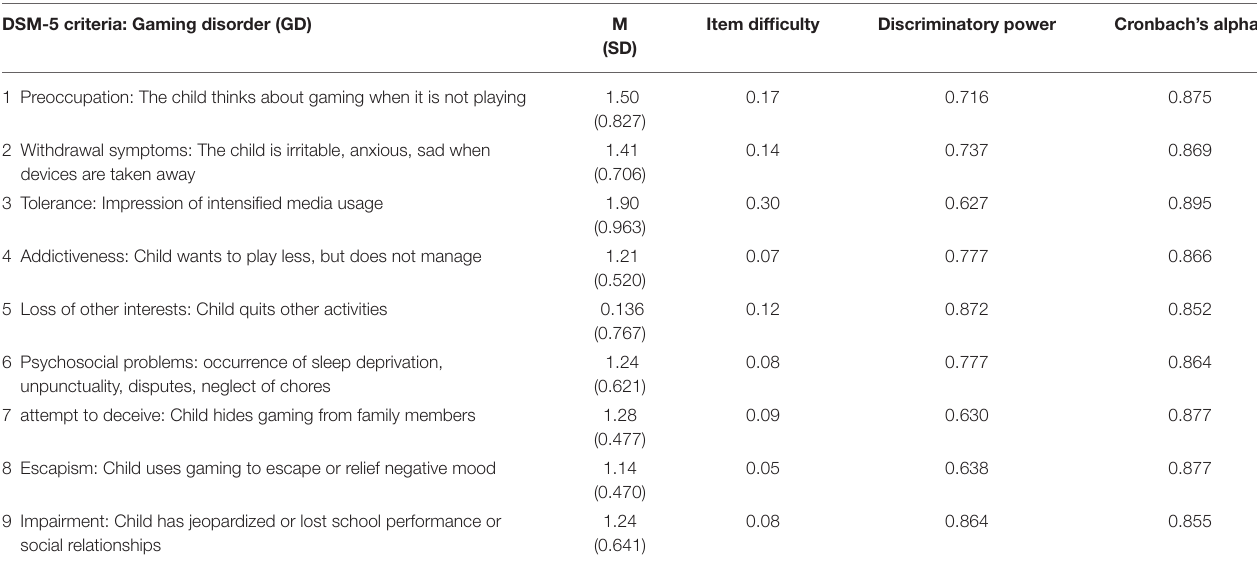
TABLE 1 | Item characteristics of the nine GD criteria ( N = 80). DSM-5 criteria: Gaming disorder